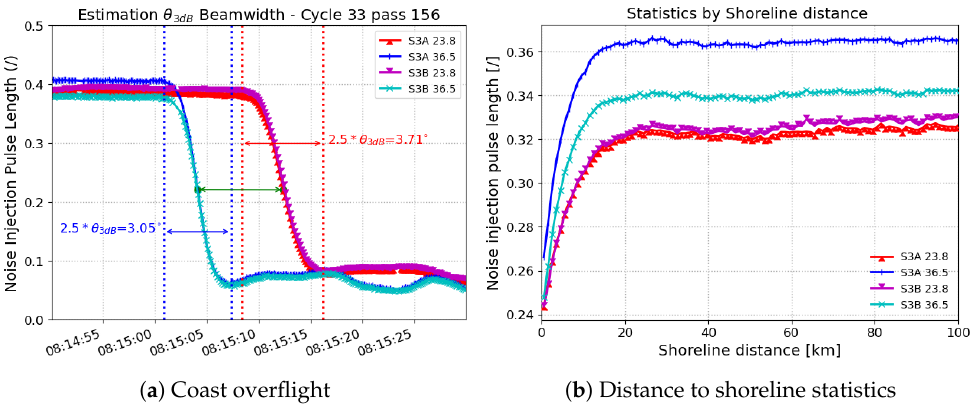
Figure 3. Raw counts for both channels (23.8 GHz, 36.5 GHz) and both instruments (Sentinel-3A, Sentinel-3B) in coastal areas during the tandem phase: ( a ) over a specific land/sea transition and ( b ) one-cycle statistics with respect to shoreline